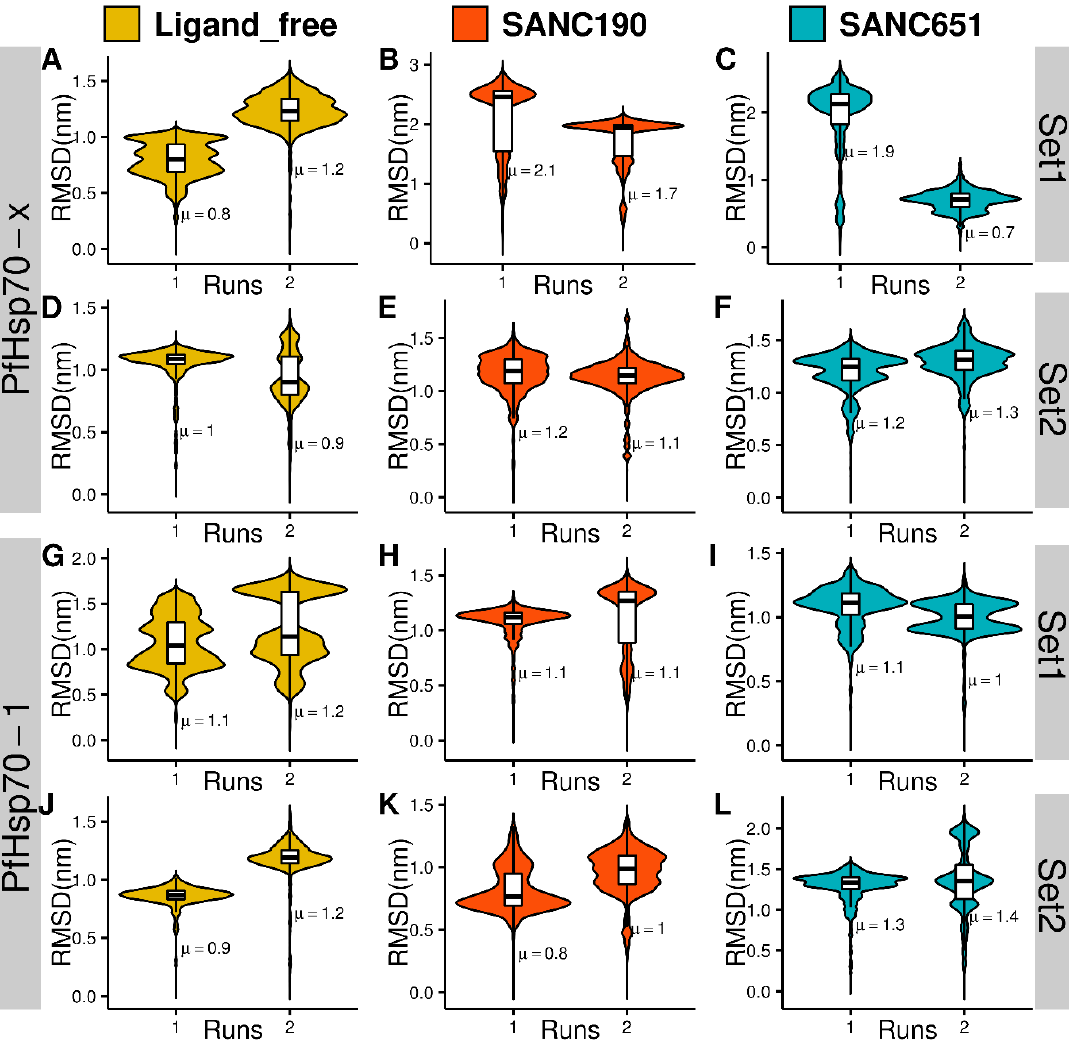
Figure 3. ( A – L ) Violin plots showing the kernel probability density distribution of protein backbone RMSDs per MD run. Density traces were plotted symmetrically to the left and right of boxplots. The width is proportional to frequency of occurrence. The overlaid boxplots highlight data range and the distribution spread. The vertical inside line represents the median value. The bars range from 25th (bottom) to 75th (top) percentile. µ denotes the calculated RMSD mean